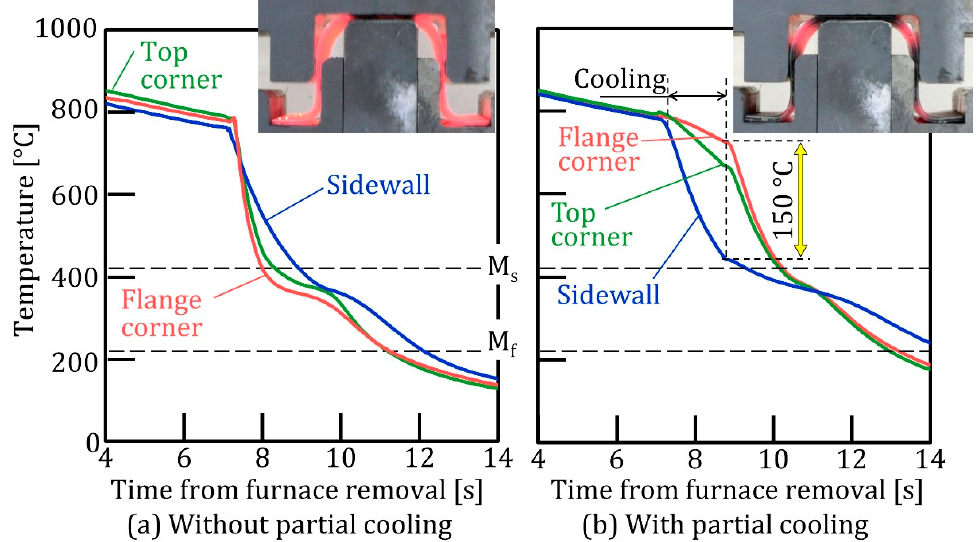
Figure 9. Variation in temperature at top and flange corners and middle of sidewall for ( a ) without and ( b ) with partial cooling.